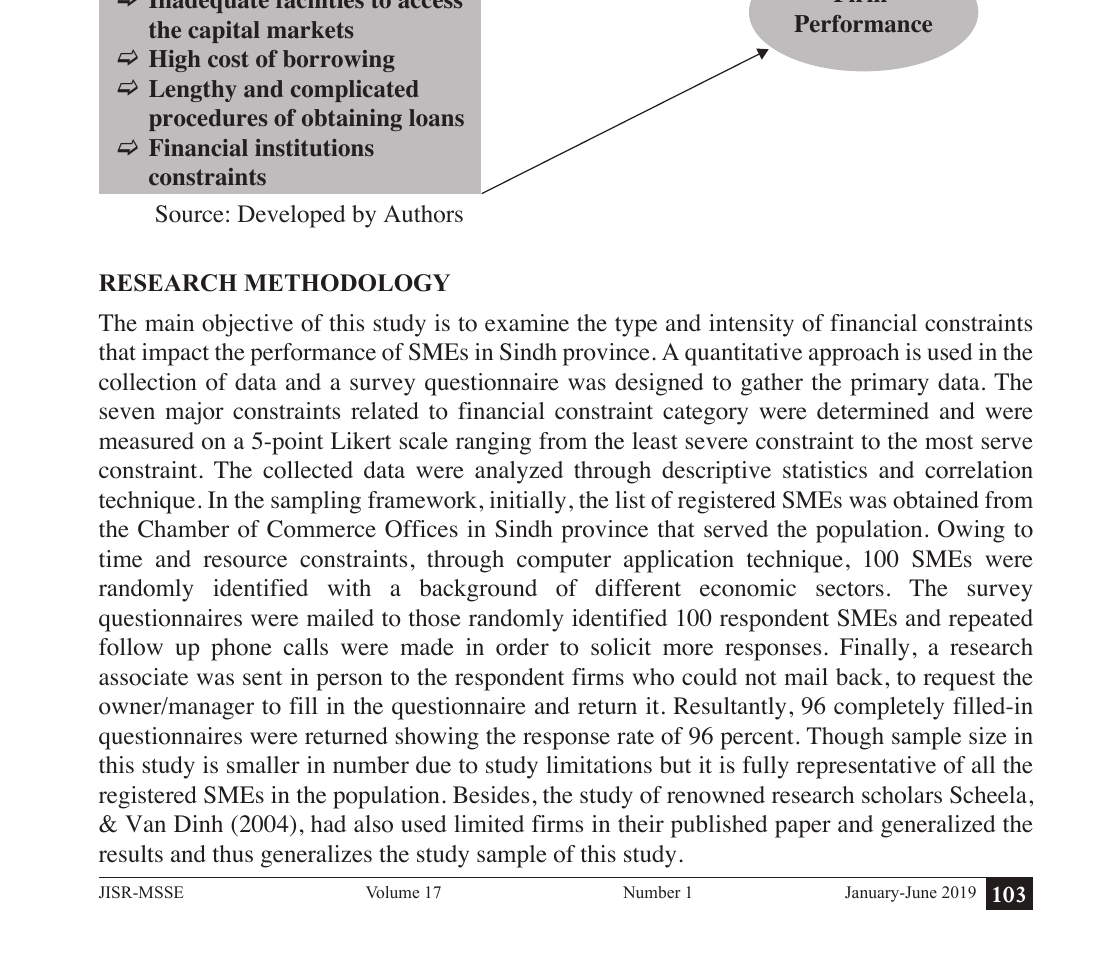
Source: Developed by Authors